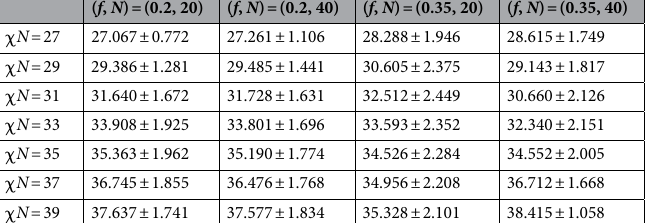
Table 7. Averages and standard deviations of estimated χ N for each unlearned χ N class for the binarized